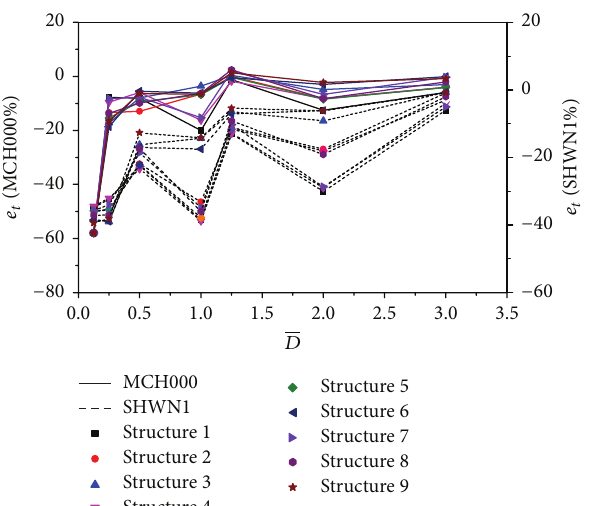
Figure 26: Interaction among structures in terms of influence coefficient 𝑒 for different distances between structures (URBAN6-6, MCH000 or SHWN1, 𝑆𝑋 ).